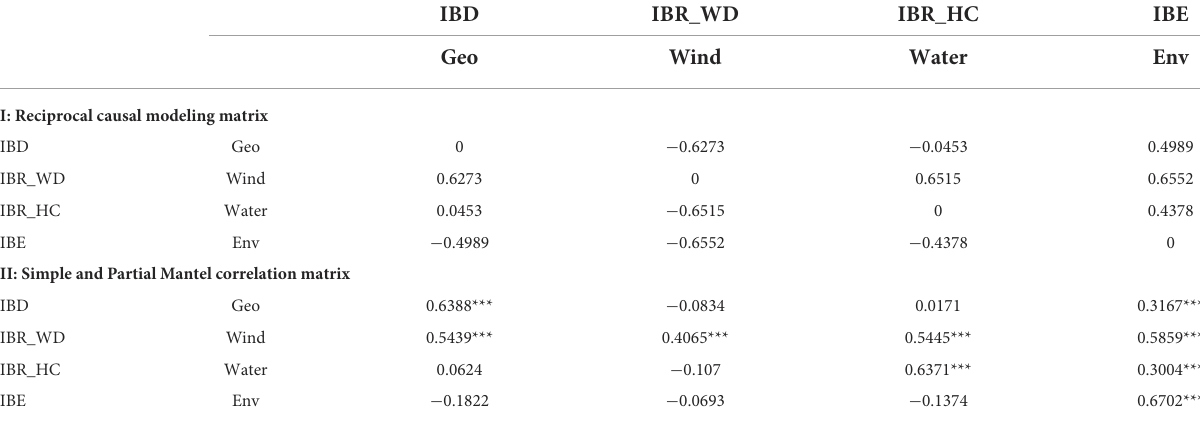
TABLE 5 Reciprocal causal modeling, partial, and simple Mantel results for IBD, IBR, and IBE for the 28 populations of Z. latifolia and each of the clusters based on 23 neutral loci.